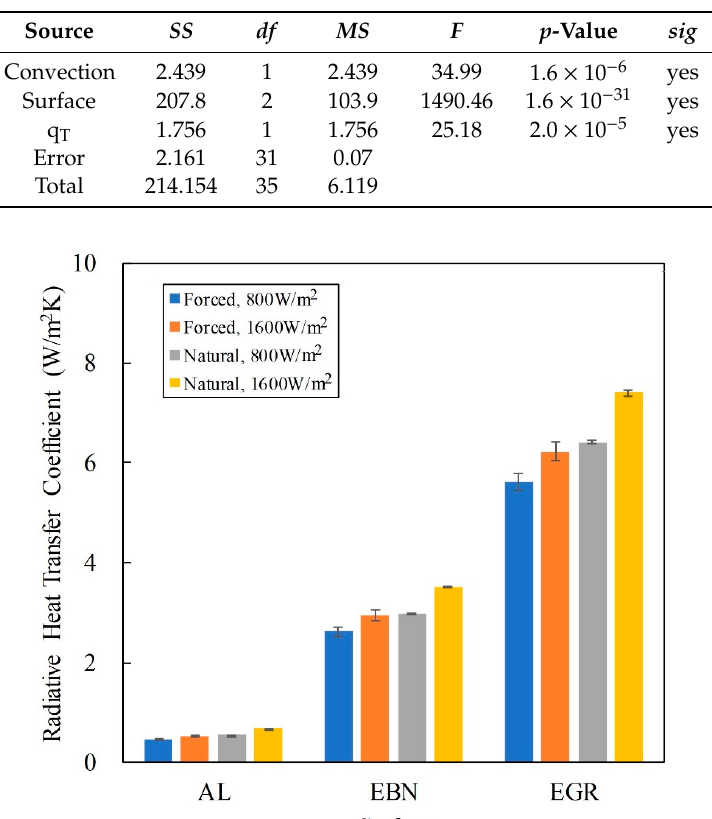
Figure 9. Effect of surface type on the radiative heat transfer coefficient. Figure 9. E ff ect of surface type on the radiative heat transfer coe ffi